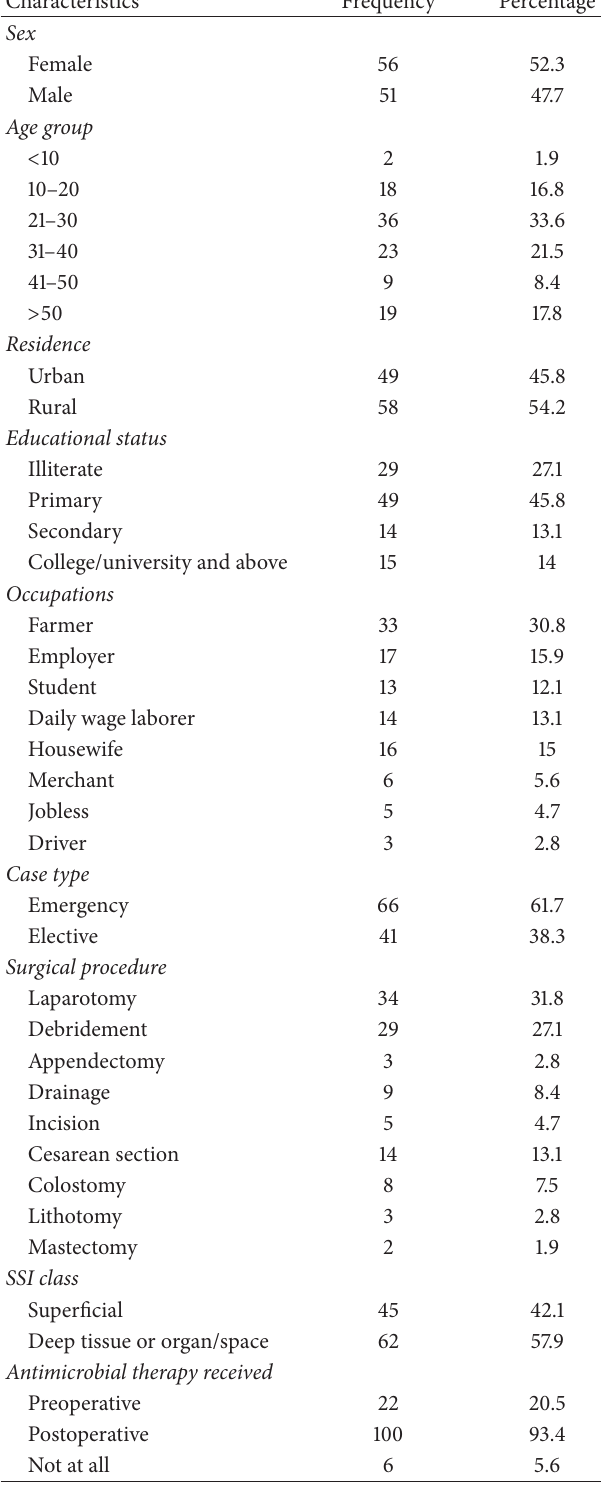
Table 1: Sociodemographic and clinical characteristics of study subjects ( 𝑛 = 107